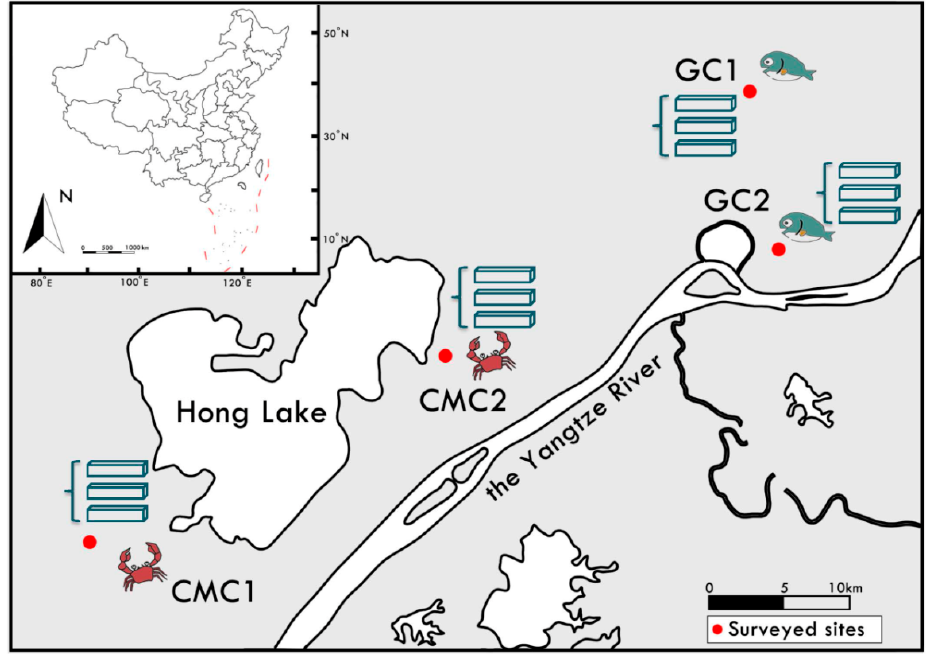
Figure 1. The location of grass carp (GC) and Chinese mitten crab (CMC) ponds sampled around Hong Lake, middle Yangtze River Basin, China. GC1, Grass carp farm 1; GC2, Grass carp farm 2; CMC1, Chinese mitten crab farm 1; CMC2, Chinese mitten crab farm 2. Three ponds were used for sediment collections in each surveyed site.